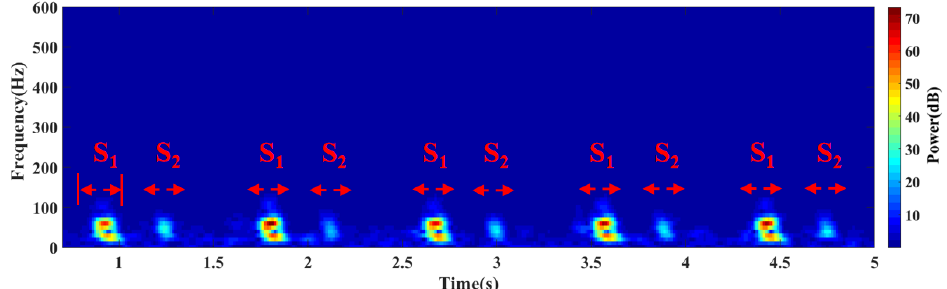
Figure 17. Heart sound signal spectrogram.